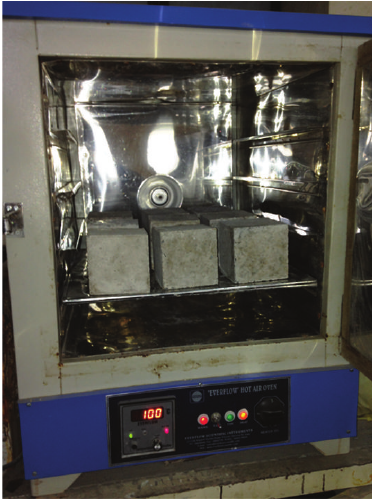
Figure 1: Geopolymer concrete specimens cured in hot air oven curing.